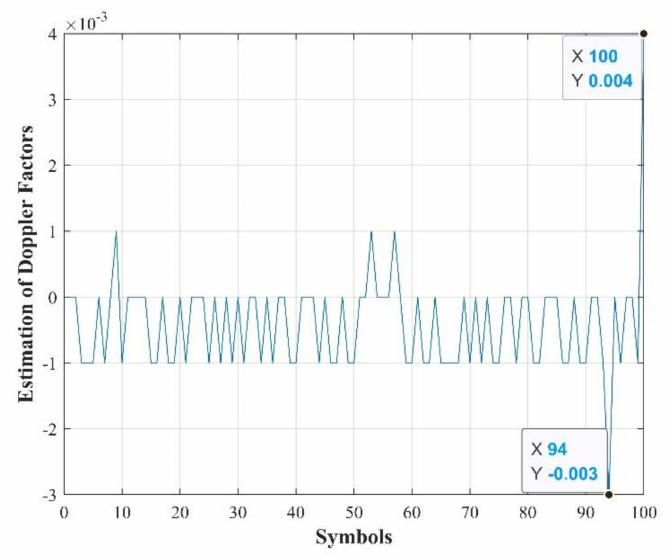
Figure 17. The 14th data packet Doppler tracking.